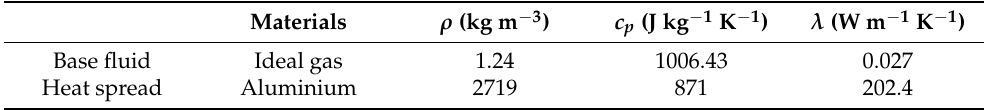
Table 3. Parameters of the heat spreader and cooling